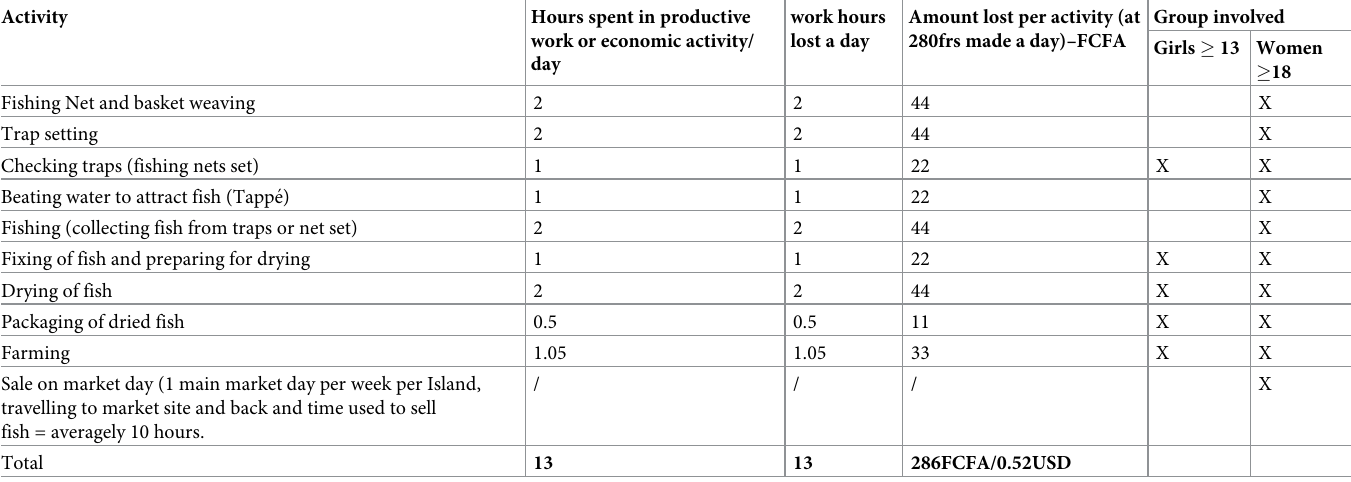
Table 7. Daily productive activity table to portray cost of disease for girls � 13 and women (based on an average income of 280 FCFA/day (from Table 4)).